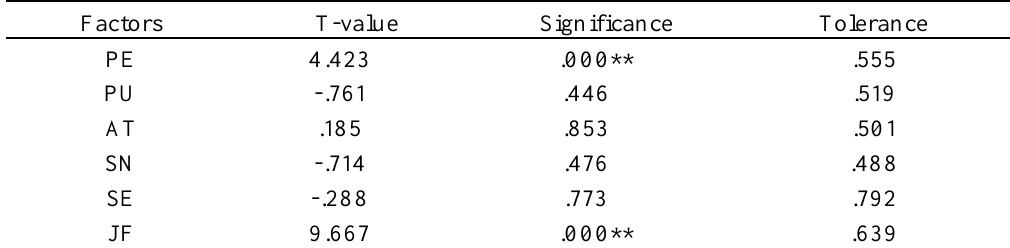
Multiple Regression Result: T-Value, Significance,